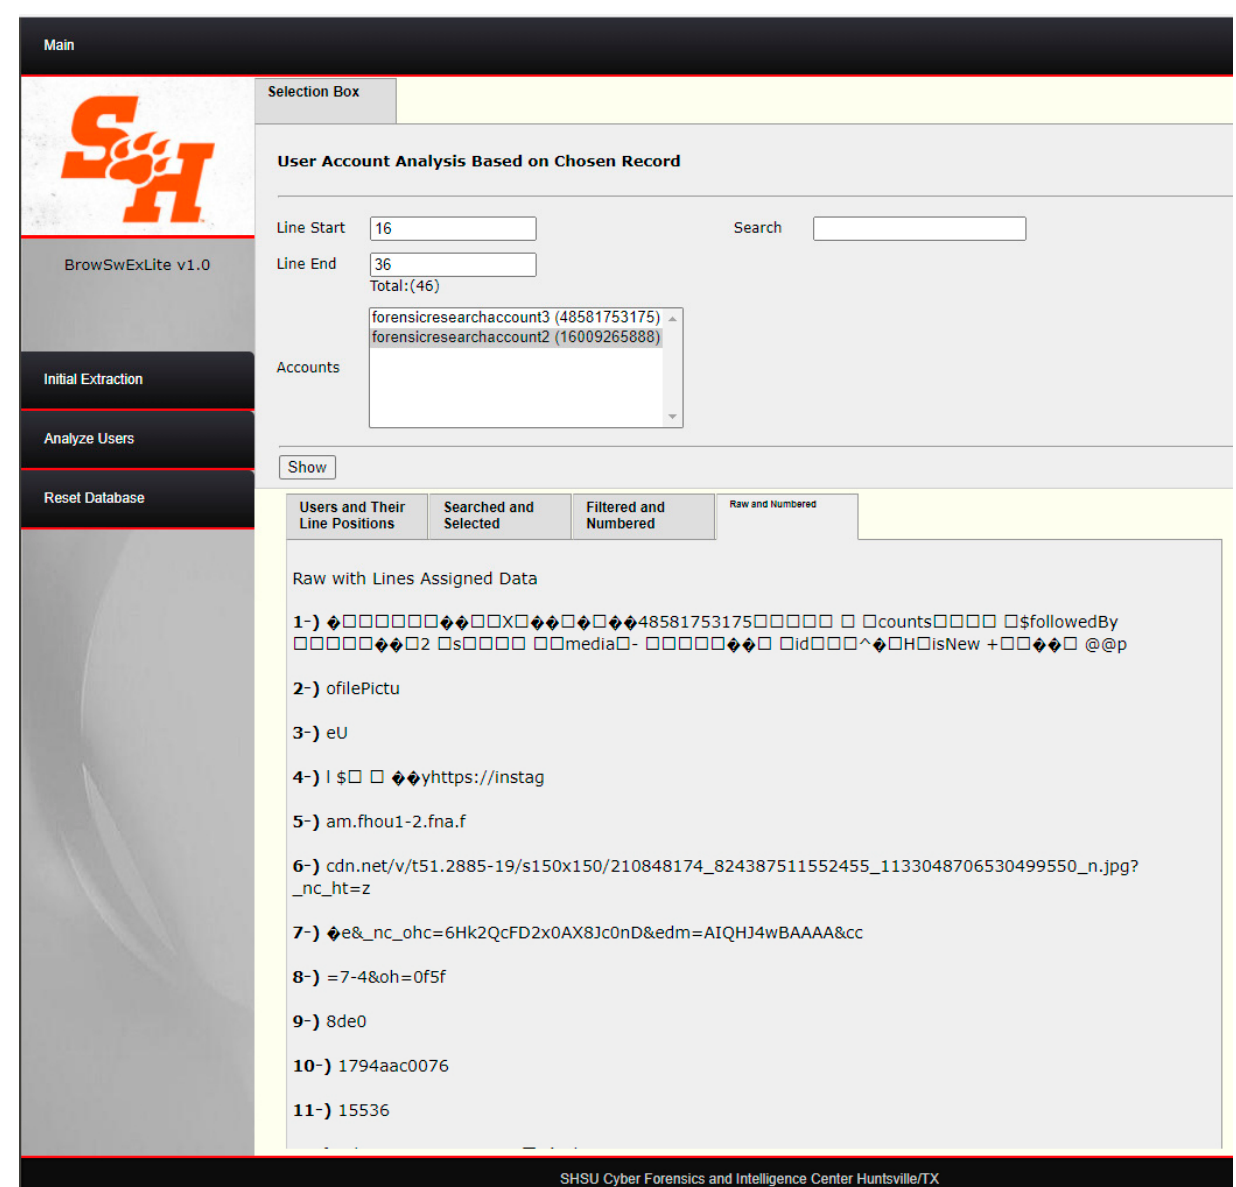
Figure 4. Displaying Records in Processed and Raw Format.